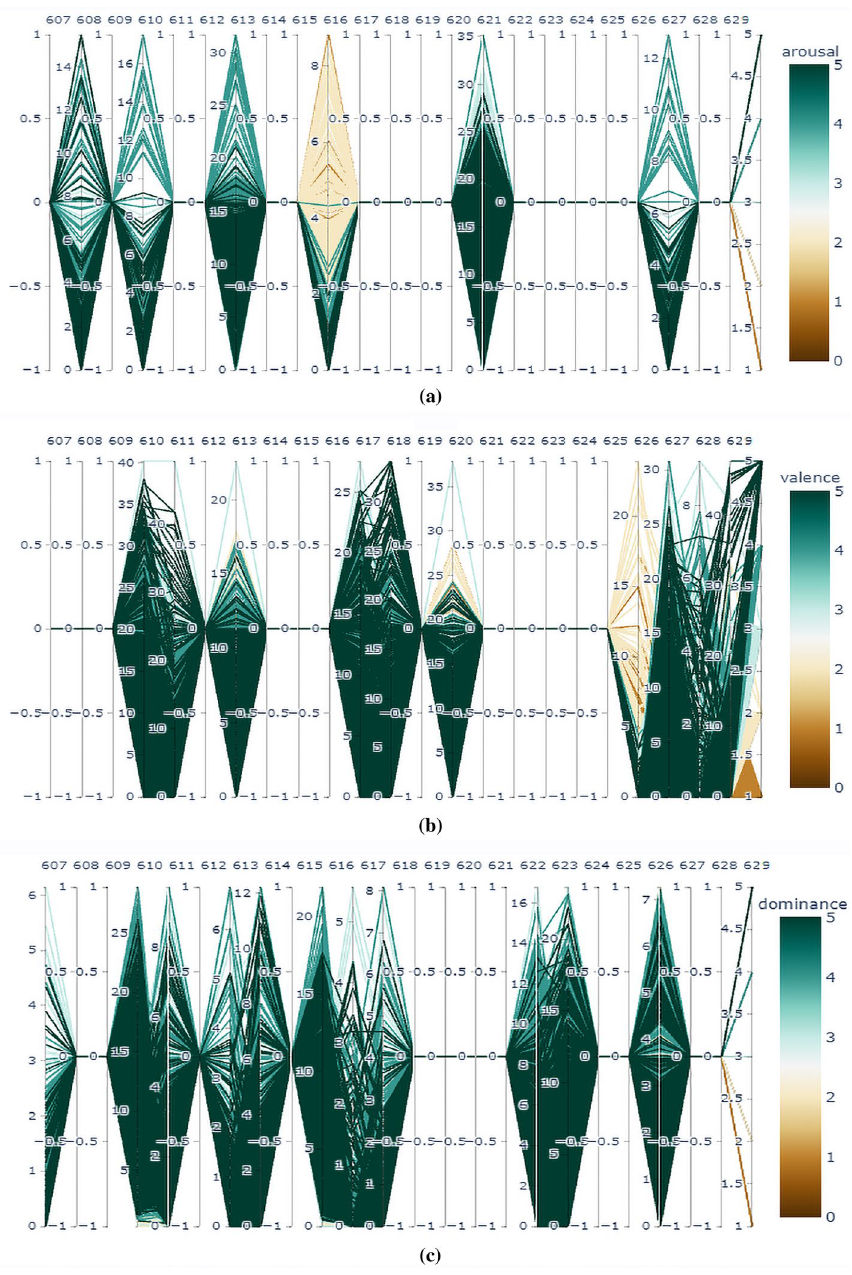
Figure 8. Impact factor of features on ( a ) arousal, ( b ) valence and ( c ) dominance using parallel co-ordinate